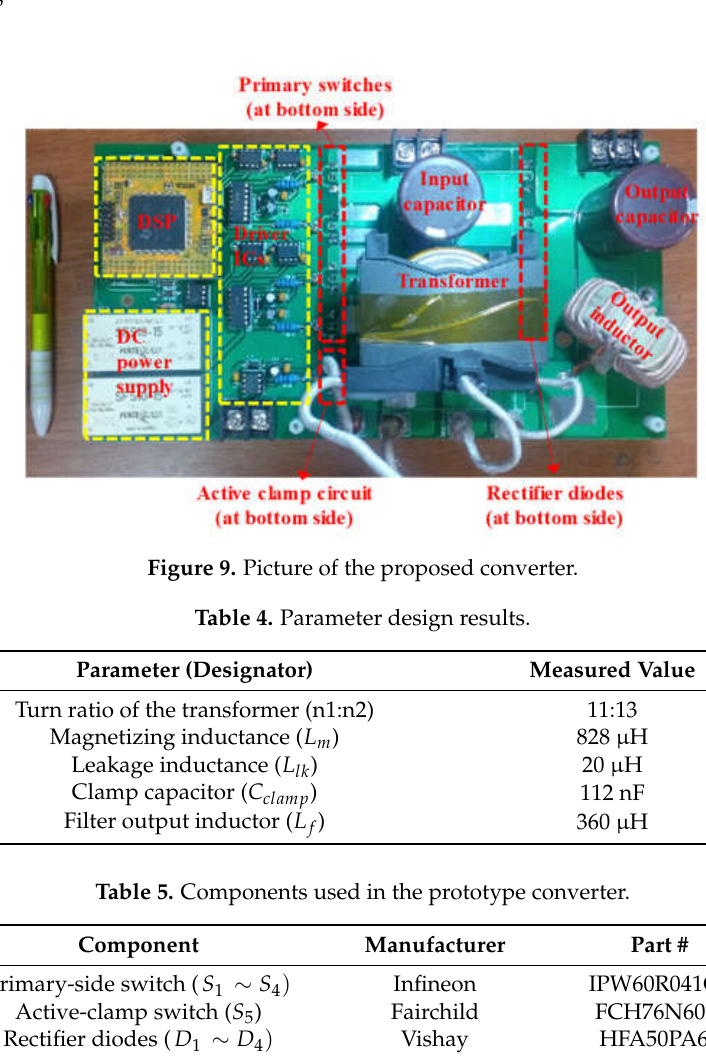
Table 5. Components used in the prototype converter.